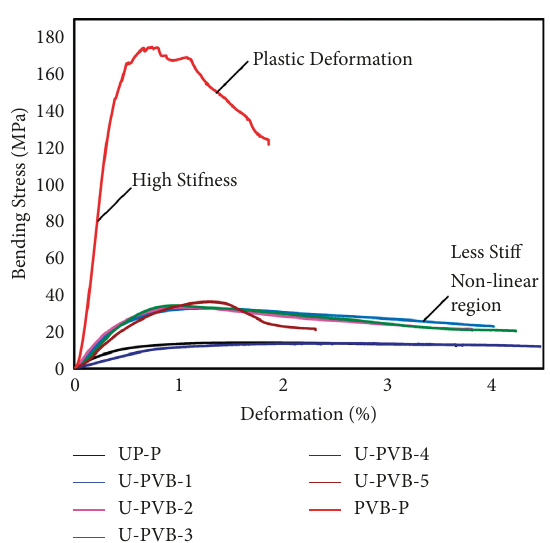
Figure 5: Force versus deformation response of developed samples of 3-point